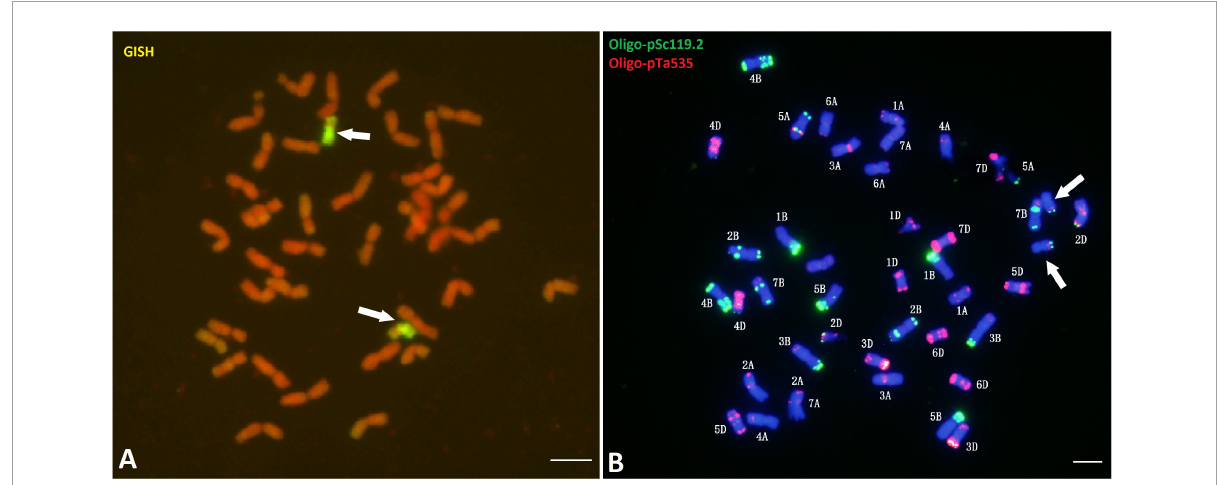
FIGURE1 Genomic in situ hybridization (GISH) and Non-denaturing fluorescence in situ hybridization (ND-FISH) analyses of mitotic metaphase chromosomes of CH51. (A) Pseudorogneria spicata total genomic DNA was used as a probe (yellow-green) in GISH analysis. Chromosomes were counterstained with propidium iodide (PI) and fluoresced red. (B) Probes Oligo-pSc119.2-1 (green) and Oligo-pTa535-1 (red) were used in ND-FISH analysis. Chromosomes were counterstained with 4’,6-diamidino-2-phenylindole (DAPI) and fluoresced blue. Arrows (A, B) point to the alien translocation chromosomes. Bars, 10 µ